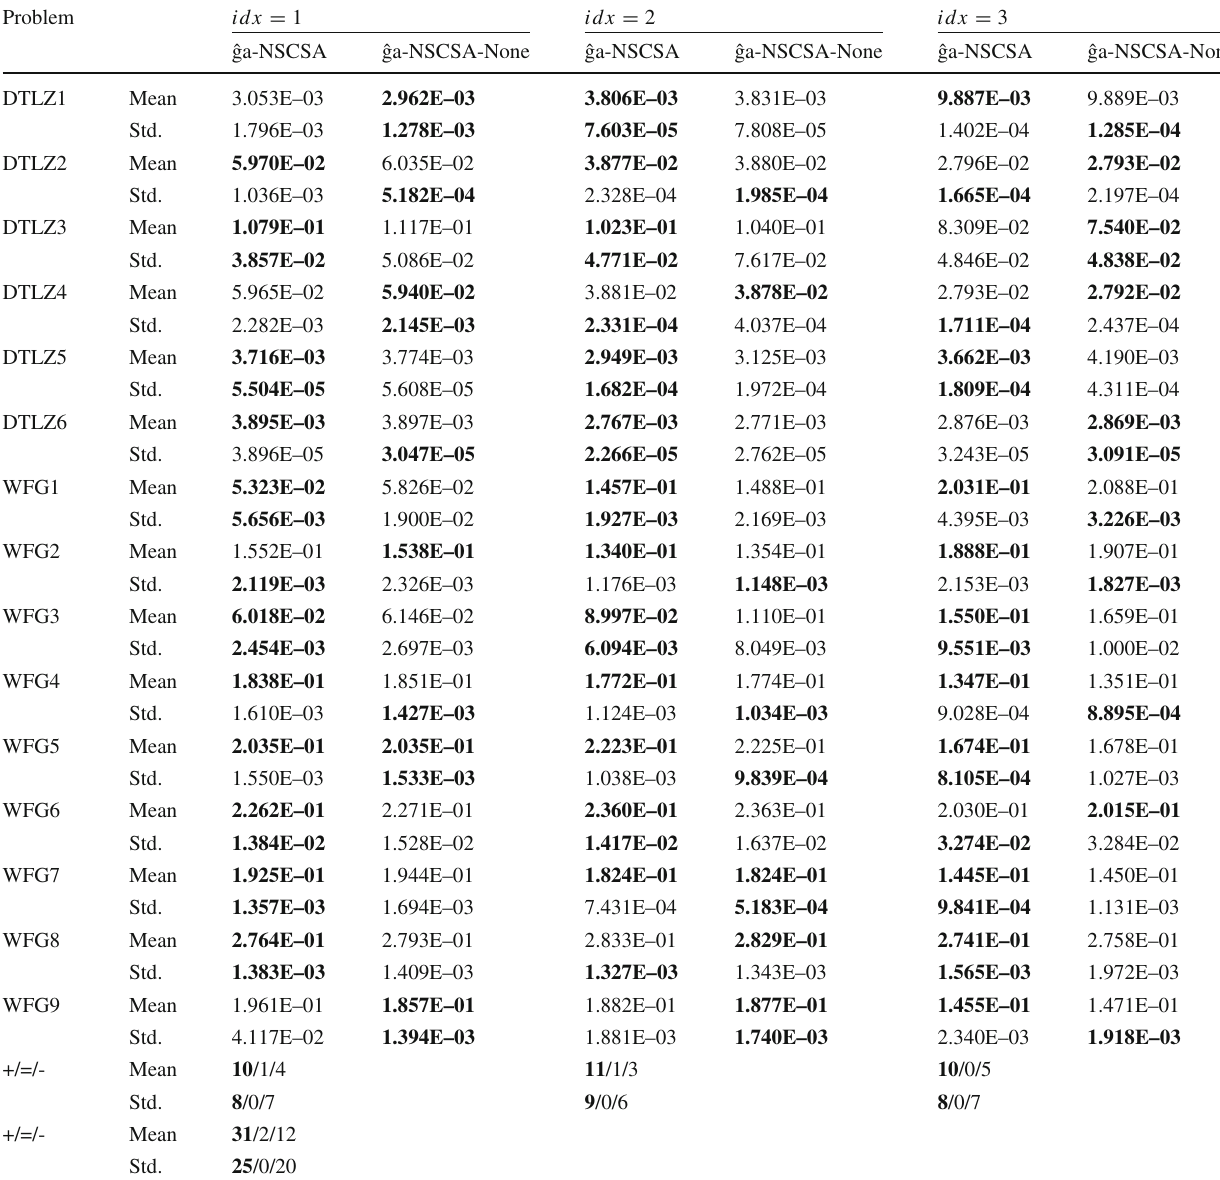
Table 6 Performances of the algorithms with and without archive